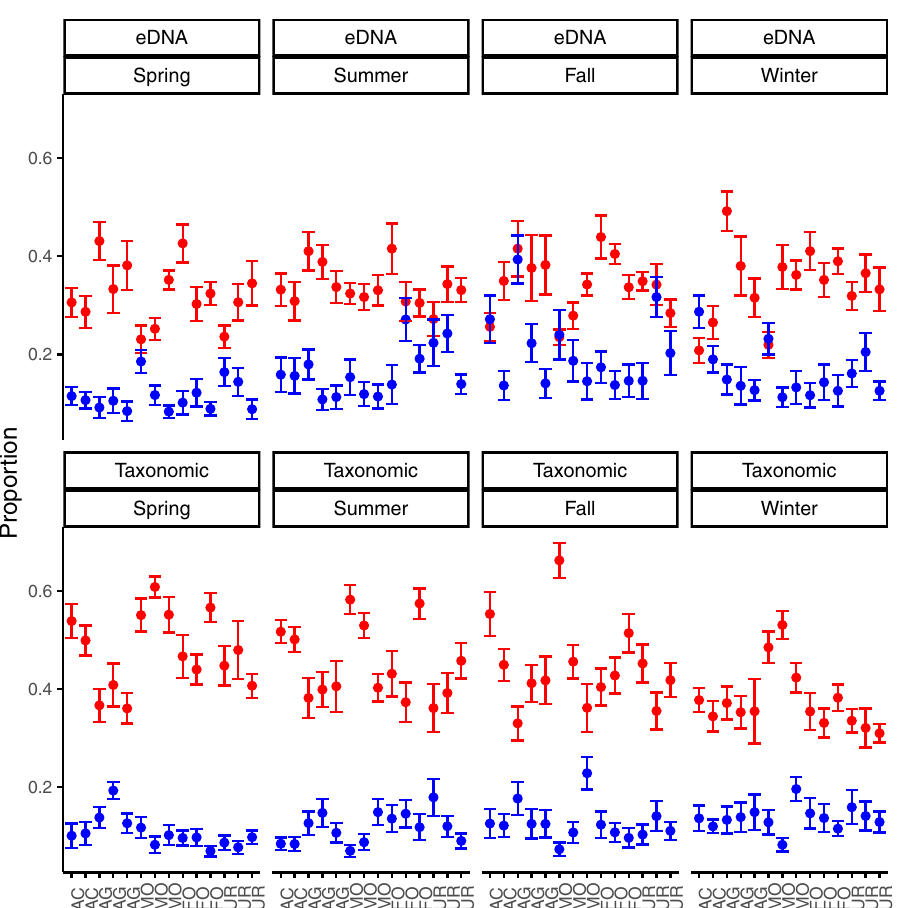
Fig. 5 Beta-diversity partitioning of traditional and eDNA biodiversity. Beta-diversity results partitioned into turnover (red) and nestedness (blue) components. Showing differences between methods (eDNA vs Taxonomic), season (Spring, Summer, Fall, Winter), with each site provided along the x- axis indicating its landuse type (AC = acid grassland, AG = agriculture, MO = moorland, FO = forest, UR = urban). Error bars are drawn to 1.5 * inter- quartile range (IQR). Turnover was signi fi cantly greater than nestedness across landuse and seasons ( p < 0.001), following a gls model that accounted for spatial autocorrelation in its variance structure via a pairwise distance matrix. Sample sizes were 56 for eDNA (average of each sites ’ 3 replicate samping) and 56 for traditional